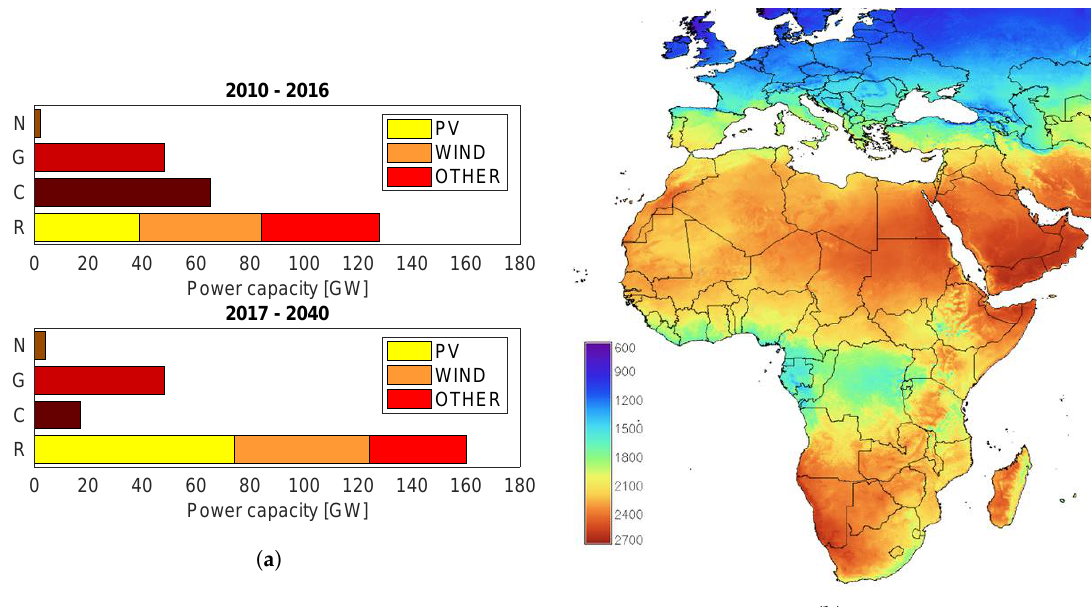
Figure 1. ( a ) Average net capacity additions per year on the global power market by type (N: nuclear, G: gas, C: coal, R: renewables) according to the World Energy Outlook 2017 [1]. ( b ) Total in-plane solar irradiation for an equator-facing plane inclined 20 ◦ from the horizontal (color bar units are in kWh/m 2 ). Figure adapted (that is, cropped from original) from Reference [3], used under CC BY 4.0